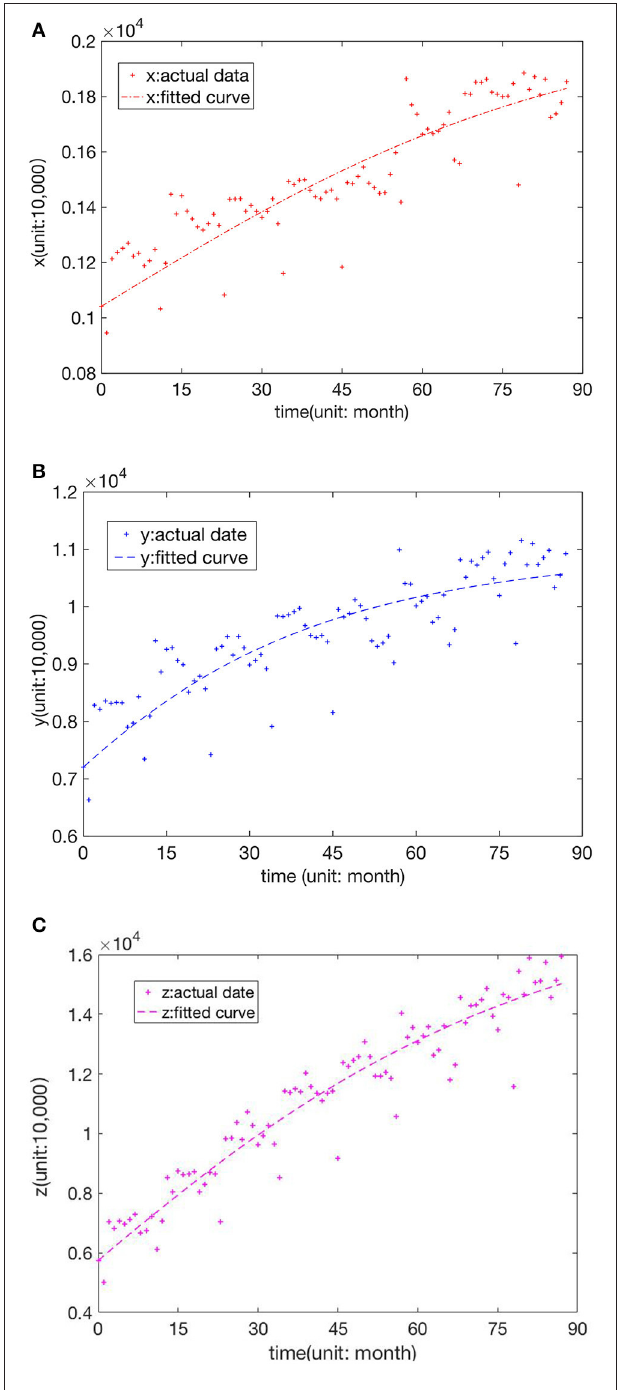
FIGURE 2 | True-date scatter plots and fitting curves of (A) FLHs, (B) SLHs, and (C)